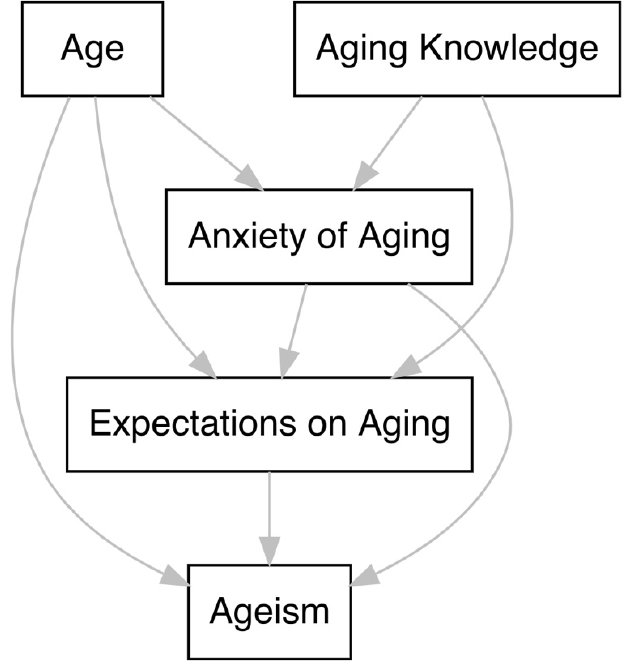
Figure 1. The hypothesized and conceptual path model framework.